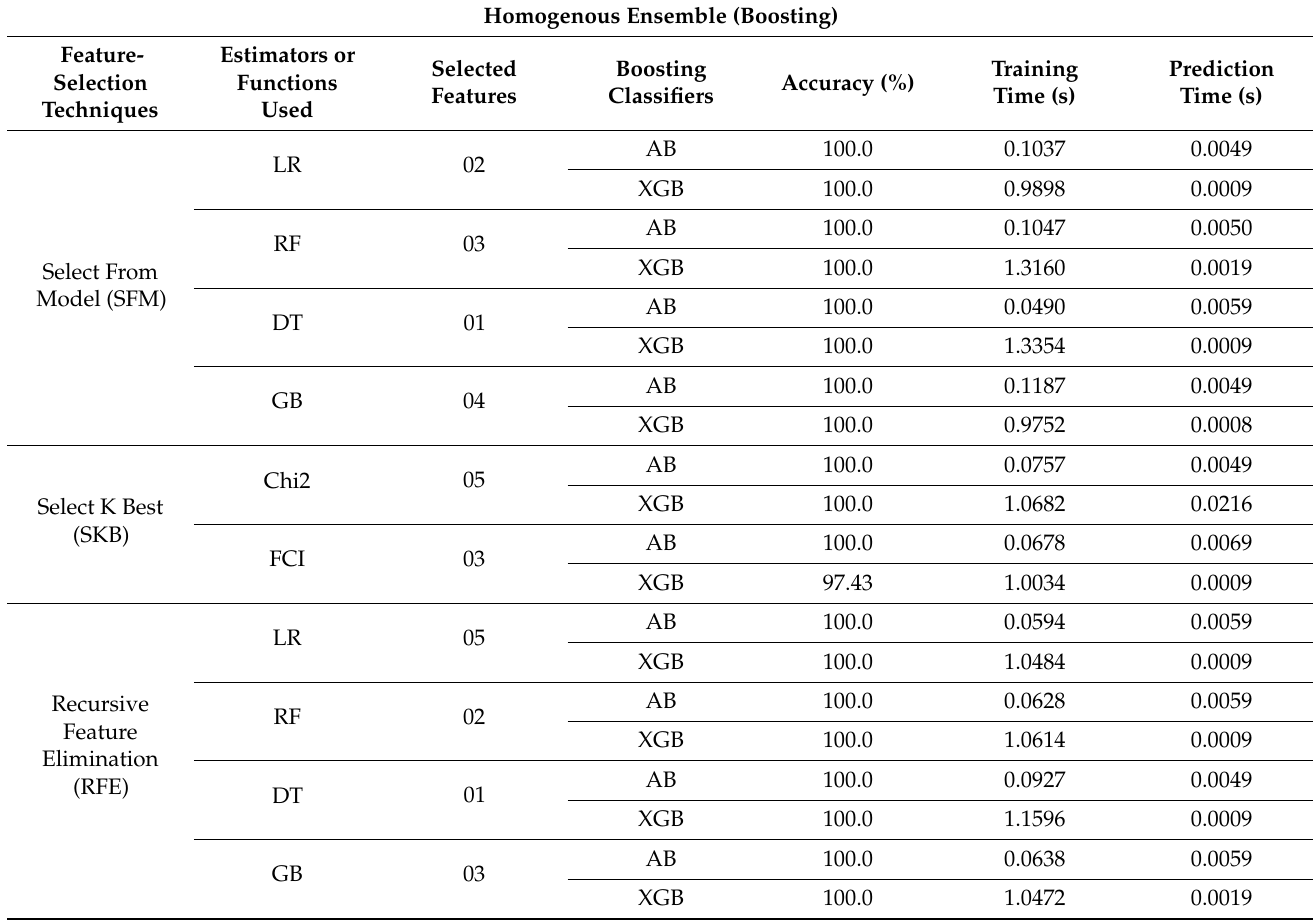
Table 5. Description of the accuracy with training and prediction time for the boosting